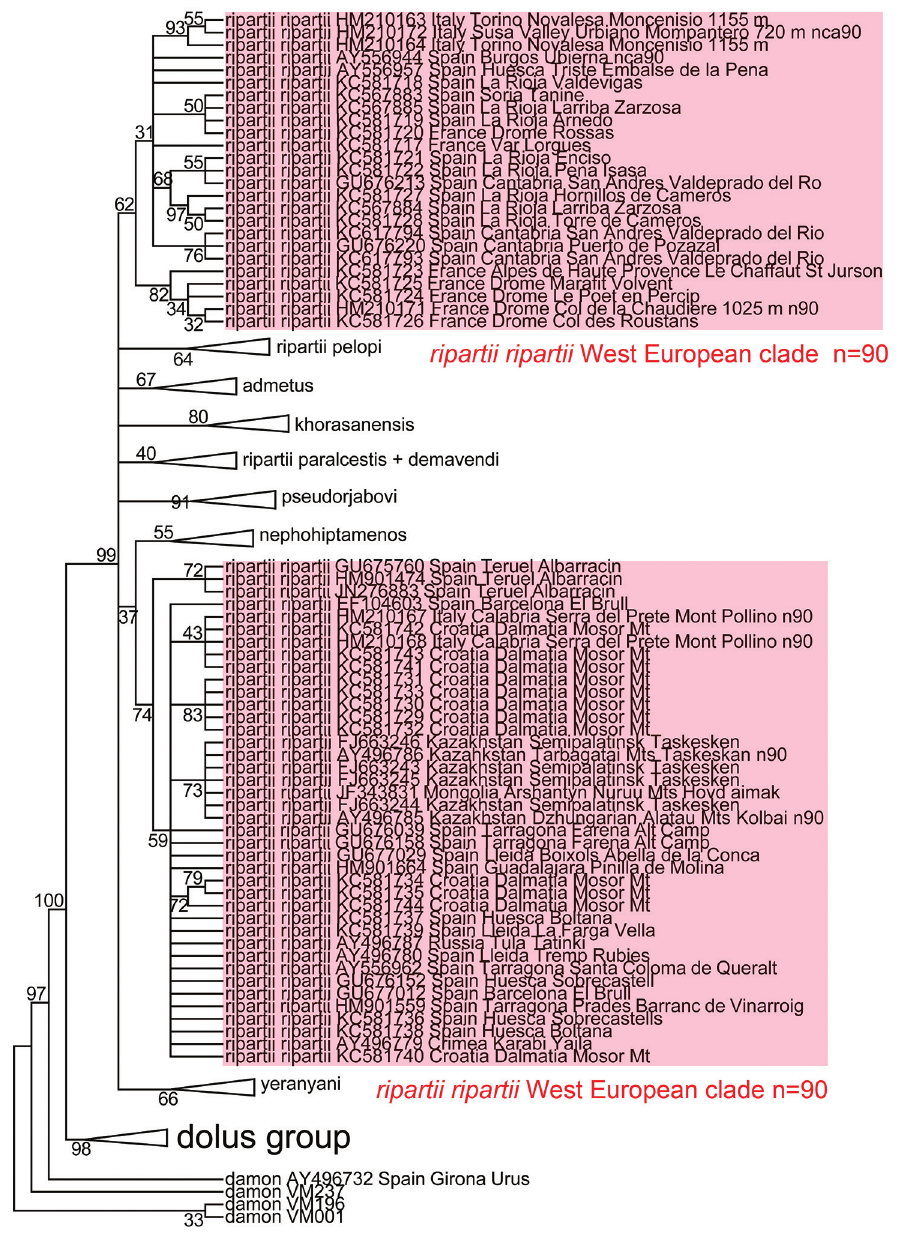
Figure 22. Fragment of the MP tree of P. admetus and P. dolus complexes based on analysis of COI barcodes and focused on details of the West-European and the “mixed” (Eurasian) clades of P. ripartii . Numbers at nodes indicate bootstrap